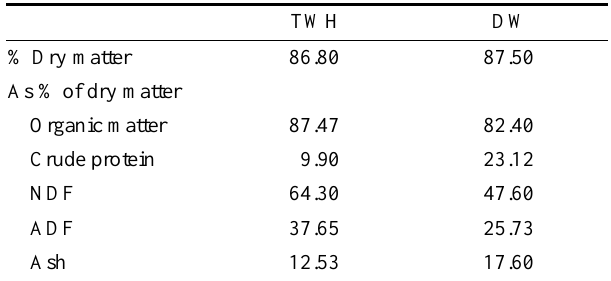
Table 1. Chemical composition of Taiwan grass hay and